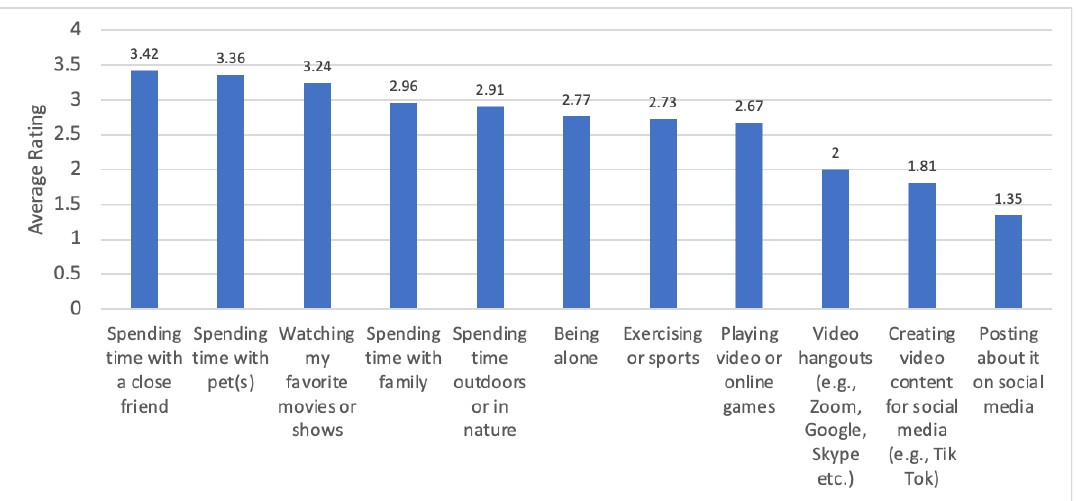
Figure 2. How spending time with pets compares to other coping strategies when adolescent pet owners are stressed.